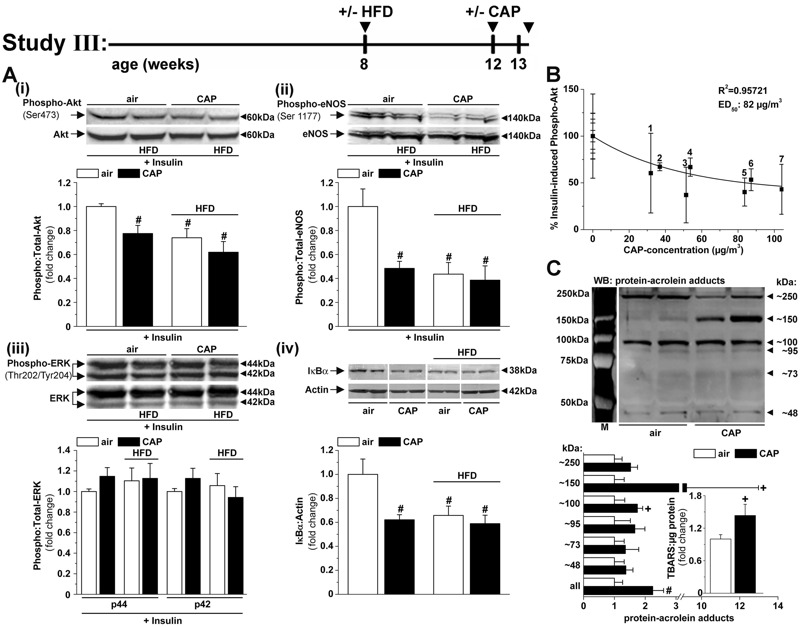
Concentrated fine particulate matter (CAP) exposure induces aortic insulin resistance and vascular inflammation. (A) Western blot analysis of the insulin-stimulated (100 nM, 15 min) phosphorylation of Akt (i), eNOS (ii) and ERK (iii) and the abundance of IκBα (iv) in aortas isolated from mice maintained on control diet (13% kcal fat) or placed on a high-fat diet (HFD, 60% kcal fat) that were exposed to air or CAP for 9 days (Study III). A continuous Western blot to detect the abundance of IκBα is shown in Figure S4A. Data are the mean ± SE normalized to controls (#
p < 0.05 vs. air-exposed control diet-fed mice; phospho-Akt, n = 8; phospho-eNOS, n = 5; phospho-ERK, n = 6; IκBα, n = 4). (B) Dose dependency of CAP-induced vascular insulin resistance was analyzed in insulin-stimulated aortas isolated from mice exposed to air or CAP for 9 or 30 days. For each exposure performed between 2010 and 2013 (see Table S4), the extent of insulin-induced Akt phosphorylation in the aorta was measured by Western analysis as described. Data are shown as discrete points of insulin-induced Akt phosphorylation (mean ± SE, in percent of air-exposed controls) and the cumulative CAP dose for each exposure, and the curve is a best fit of a first-order exponential equation [(y = 39.0+ 60.9exp (–x/49.2); y = percent insulin-induced phospho-Akt, x = CAP concentration in micrograms per cubic meter] to the data. (C) Western blot analysis of the plasmatic abundance of protein–acrolein adducts (loading controls are shown in Figure S4C) and plasma TBARS levels (C, inset) in mice exposed to air or CAP for 9 days. Data are mean ± SE (#
p < 0.05, +
p < 0.1 air vs. CAP; n = 5). ED50, median effective dose; TBARS, thiobarbituric acid reactive substances.